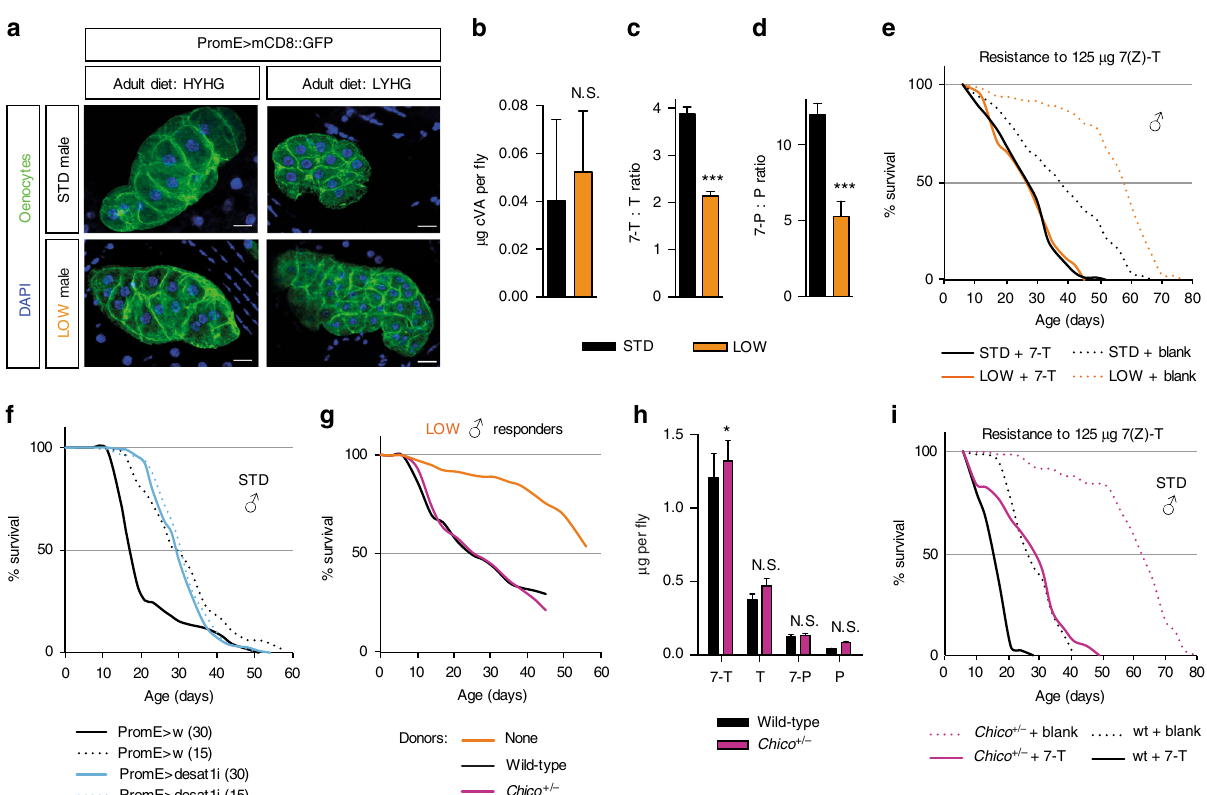
Fig. 7 Developmental diet and chico regulate autotoxin production and resistance. a Ventral oenocytes of 2-week STD or LOW adult males on HYHG or LYHG. Scale bar = 5 μ m. b – d LOW males have a similar amount of cis -vaccenyl acetate ( b cVA) but a lower ratio of 7-unsaturated:saturated C23 ( c 7-T:T) and C25 ( d 7-P:P) hydrocarbons than STD males on HYHG at 3 weeks of age ( n = 6). *** p < 0.001, two-tailed t -test. e Supplementation with 125 μ g 7(Z)-T (7-T) shortens the lifespan of STD and LOW males and abrogates the survival difference observed in unsupplemented (blank) vials. Ten fl ies were used per HYHG vial. f Doubling housing density from 15 to 30 fl ies per vial decreases the survival of control ( PromE TS > w ) but not Desat1 RNAi ( PromE TS > Desat1i ) STD males on HYHG. g , h chico +/ − and wild-type STD males produce similar levels of autotoxin activity g and cuticular hydrocarbons at 3 weeks of age on HYHG ( n = 5) h . * p < 0.05, two-way ANOVA followed by the Bonferroni multiple comparisons test. i Survival of STD chico + / − and chico + / + males (10 per vial) on HYHG supplemented with 125 μ g 7(Z)-T (7-T) or with hexane (blank). b – d , h : Error bars show 1